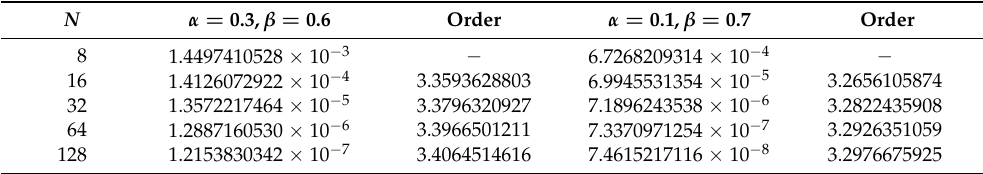
Table 4. Maximum errors and decay rate with M = 2 N .